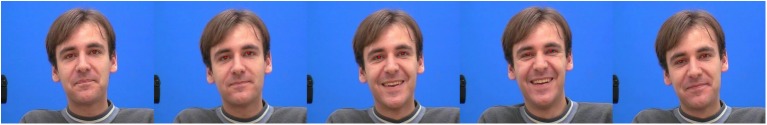
Sample results of eye tracking on Talking Face Video, selected from the 1th, 11th, 30th, 50th and 100th sequences in Talking Face Video.